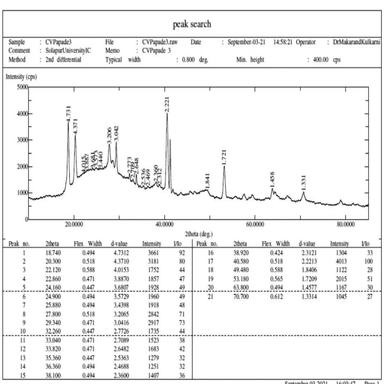
XRD analysis of 0.5 % nano mixed -PCM.